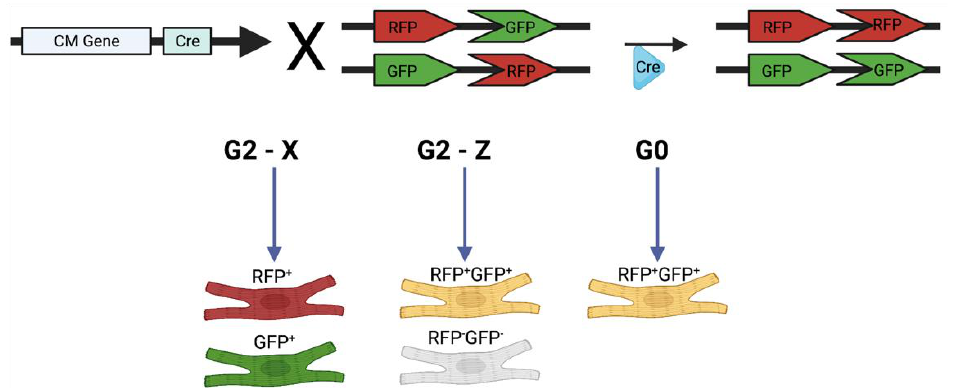
Figure 1. Schematic detailing how mosaic analysis with double markers (MADMs) works. In MADMs, the N-terminus of either the GFP or RFP allele, and the C-terminus of the other reporter, are knocked in on the same chromosome. After DNA replication, Cre/LoxP technology induces intrachromosomal recombination, and G2-X segregation generates two cells, one of which expresses RFP, and the other expresses GFP. G2-Z segregation results in 1 double-positive cell (yellow color) and 1 negative (no color) cell. Recombination in the G0 phase results in 1 double-labeled yellow cell. Created using BioRender.com, 29 March 2022.